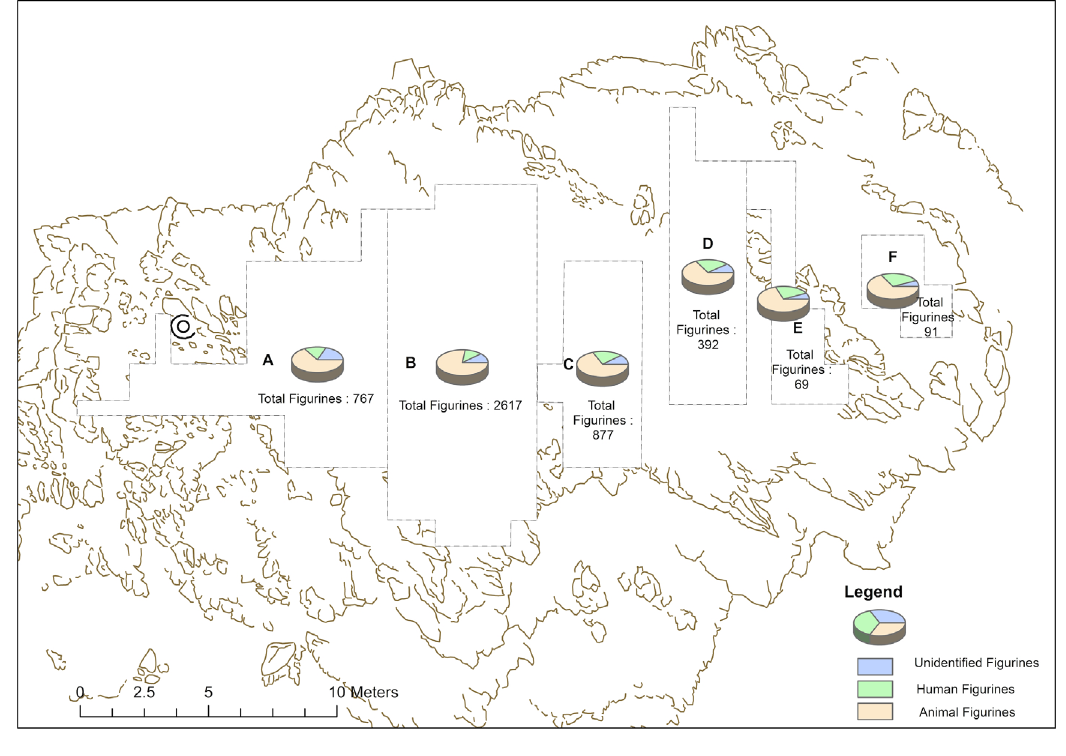
Figure 6: GIS map showing the distribution of figurine fragments on the site, represented as percentages within the trench areas (A: upper terrace; B: rock clefts; C-F: lower